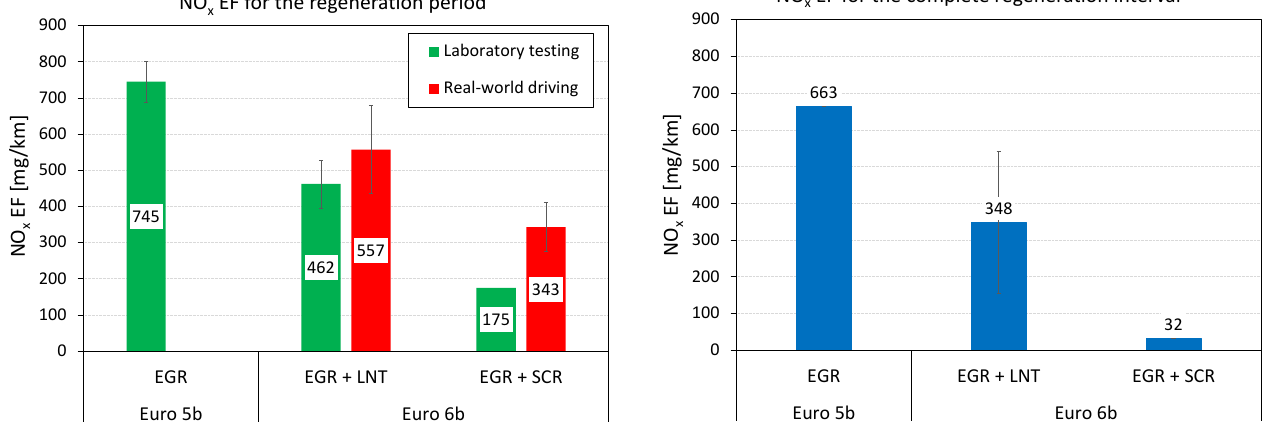
Figure 12. NO x EF for the regeneration period ( left ) and for the complete regeneration interval ( right ).